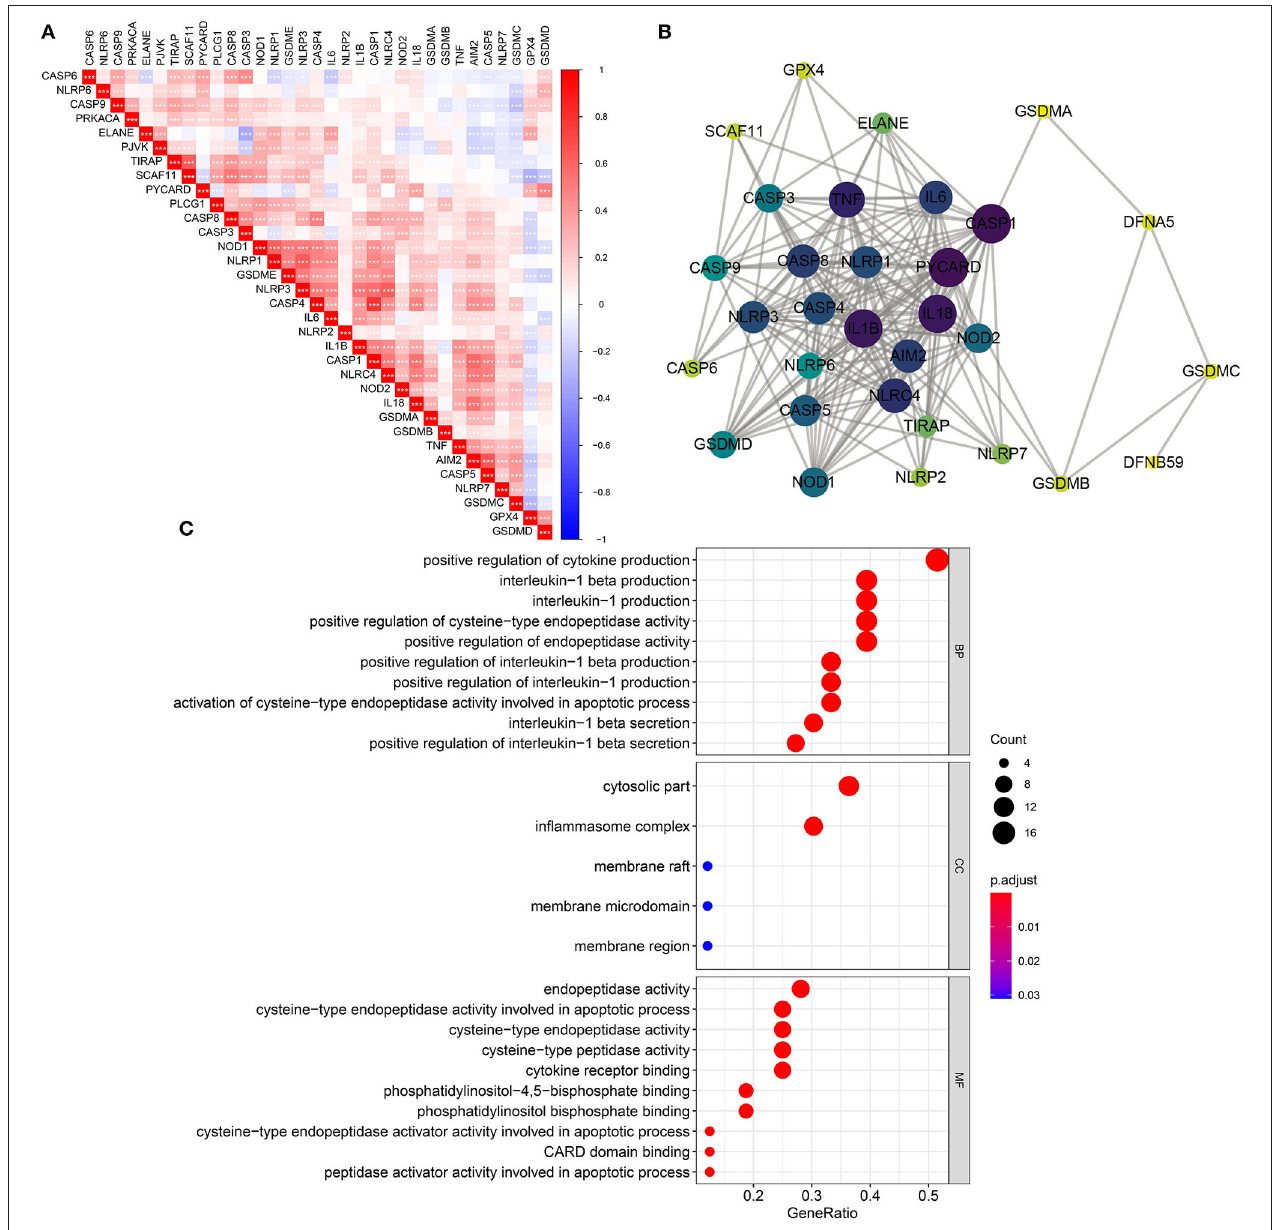
FIGURE 2 | Biological functions and interactions of pyroptosis-related genes in breast cancer. (A) Correlations between pyroptosis-related genes. * p < 0.05; ** p < 0.01; *** p < 0.001. The darker the color, the stronger the correlation. (B) A PPI network of pyroptosis-related genes. The larger the circle, the greater the degree. (C) Biological process (BP), cellular component (CC), and molecular function (MF) enrichment analyses results of pyroptosis-related genes.